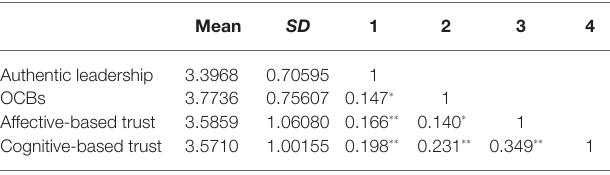
TABLE 1 | Descriptive statistics, mean, standard deviation (SD), and correlation of the variables.